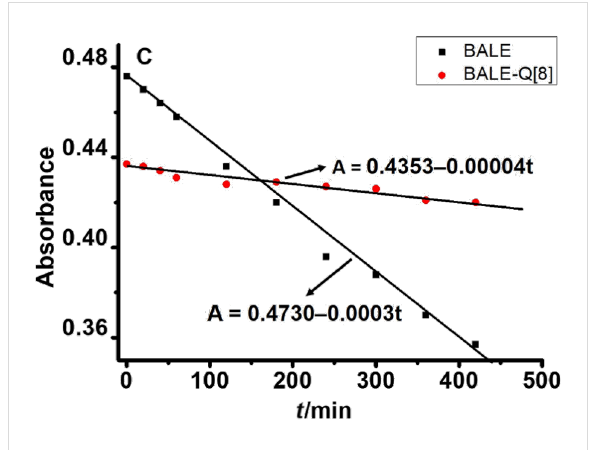
Figure 7: The stability curve of UV–vis absorption obtained for an isoconcentration of BALE and the BALE–Q[8] inclusion complex with